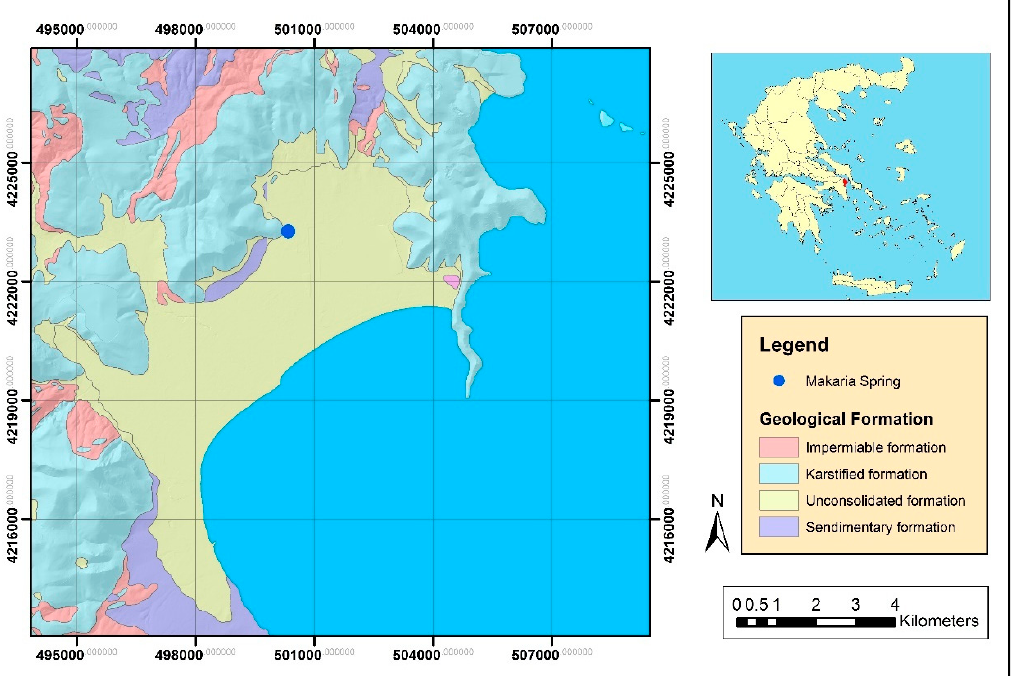
Figure 1. Hydrogeological system of